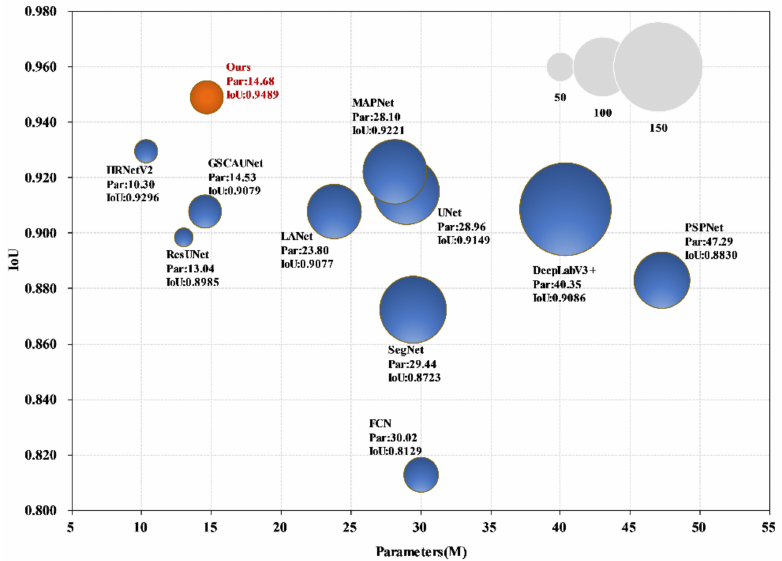
Figure 16. Comparison of complexity and performance obtained by different methods. IoU and the number of parameters of each approach are